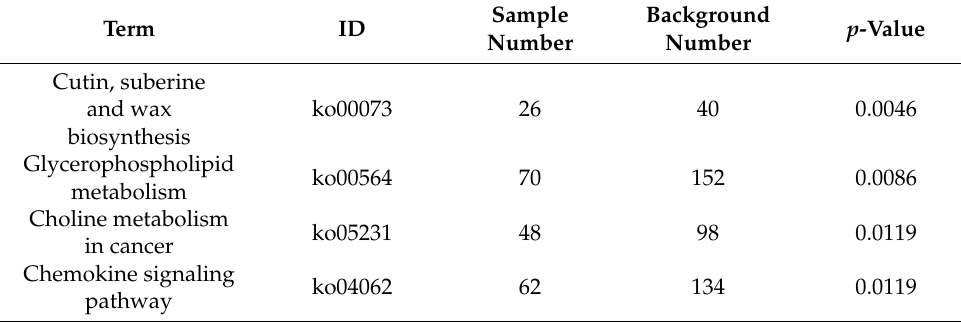
Table 3. KEGG significant enrichment analysis of